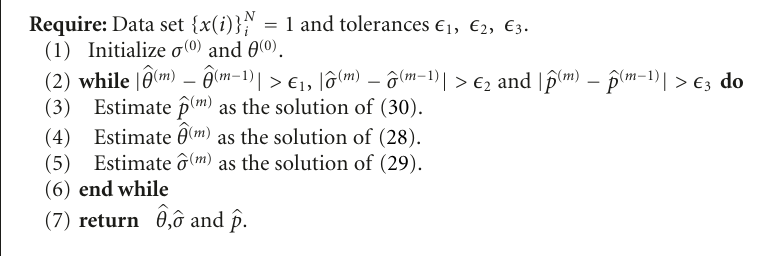
Algorithm 1: Multiparameter estimation